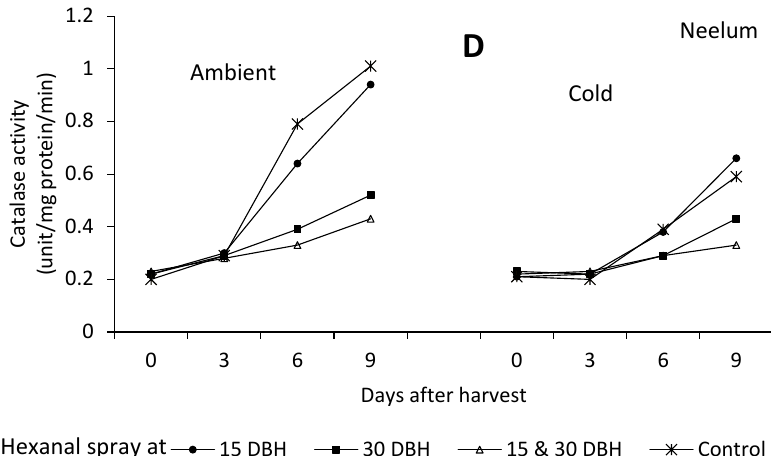
Figure 6. Periodical changes in the PME ( A ), PG ( B ), Peroxidase ( C ) and Catalase ( D ) activities of the hexane-treated and control mango fruit cv. Neelum during storage under ambient and cold storage conditions (up to 9 days). The vertical bars represent the mean value of four replicates. PME — Pectinmethylesterase; PG — Polygalacturonase.